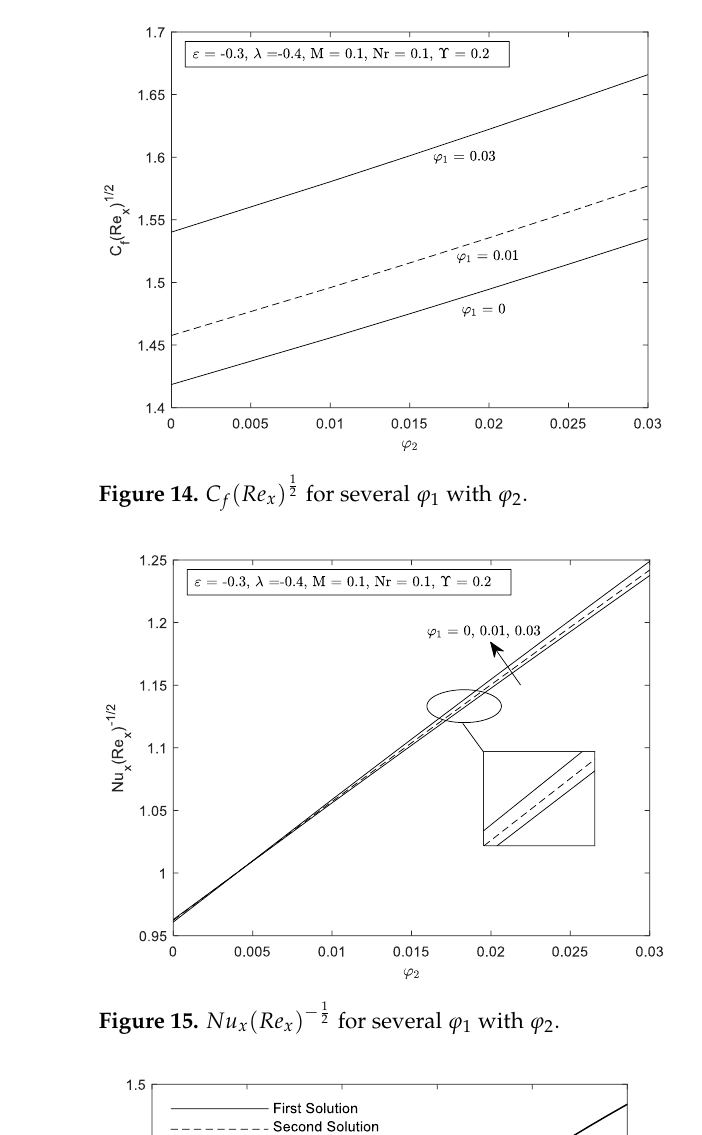
Figure 15. 𝑁𝑢 𝒙 (𝑅𝑒 𝒙 ) − Figure 15. Nu x ( Re x ) − Figure 15. 𝑁𝑢 𝒙 (𝑅𝑒 𝒙 ) − Figure 15. 𝑁𝑢 𝒙 (𝑅𝑒 𝒙 ) −